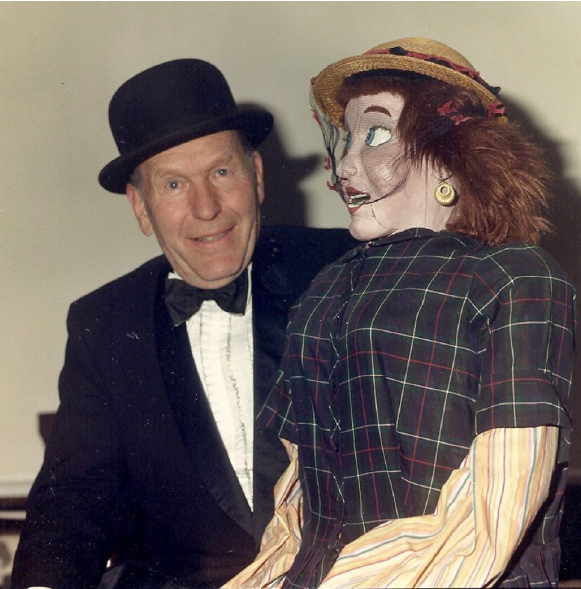
Figure 1 | Zelda Zilch with Burke Bradbury, Lower Providence, PA, USA, 1992.